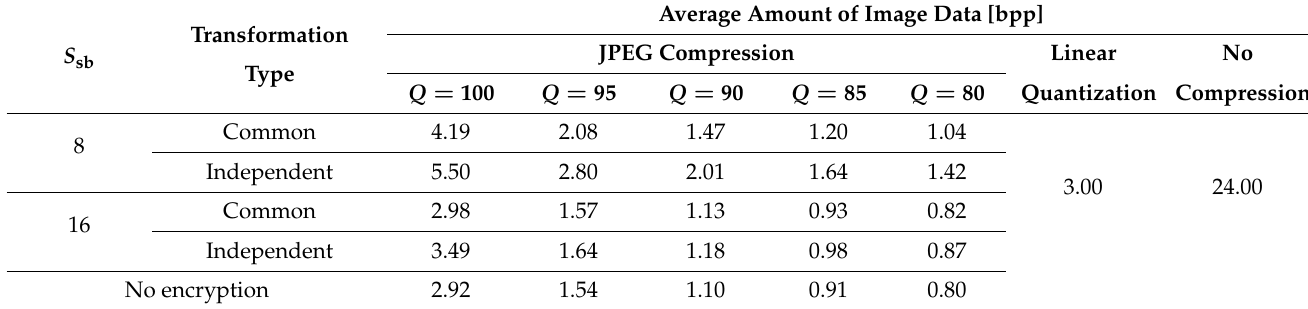
Table 1. Average amount of image data.